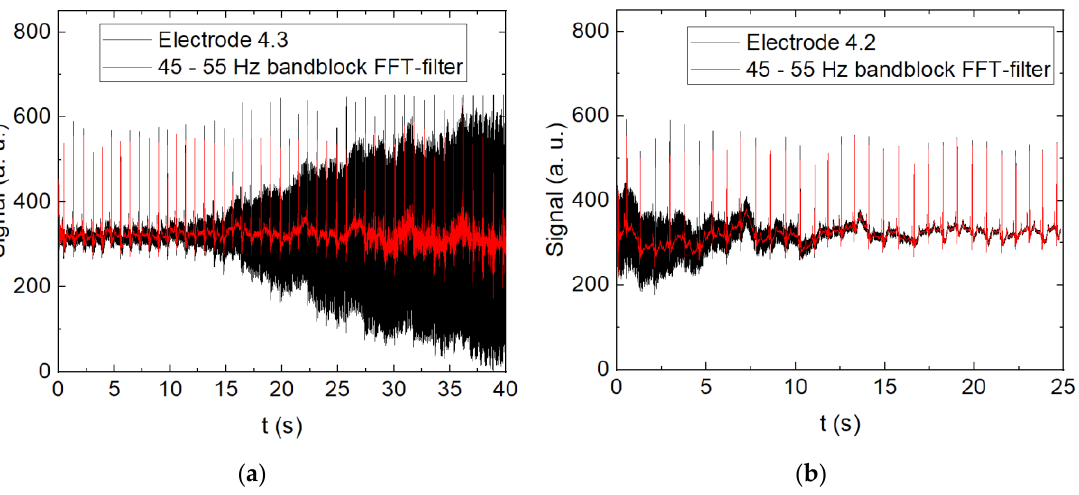
Figure 7. ECG measurement with textile electrodes: ( a ) electrode 4.3 on pre-wetted skin during drying; ( b ) electrode 4.2.